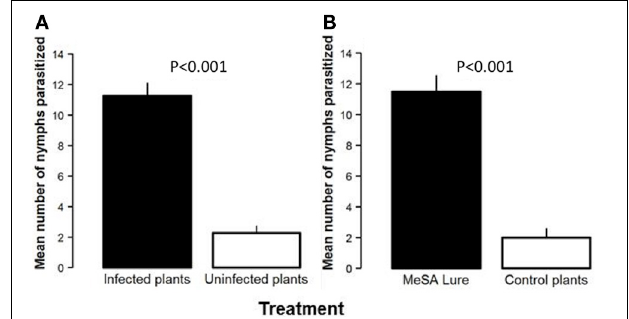
FIGURE 3 | Number of Diaphorina citri nymphs parasitized by Tamarixia radiata on: Las-infected vs. uninfected plants (A) or on uninfected plants treated with a methyl salicylate (MeSA) lure vs. uninfected plants left untreated (B).